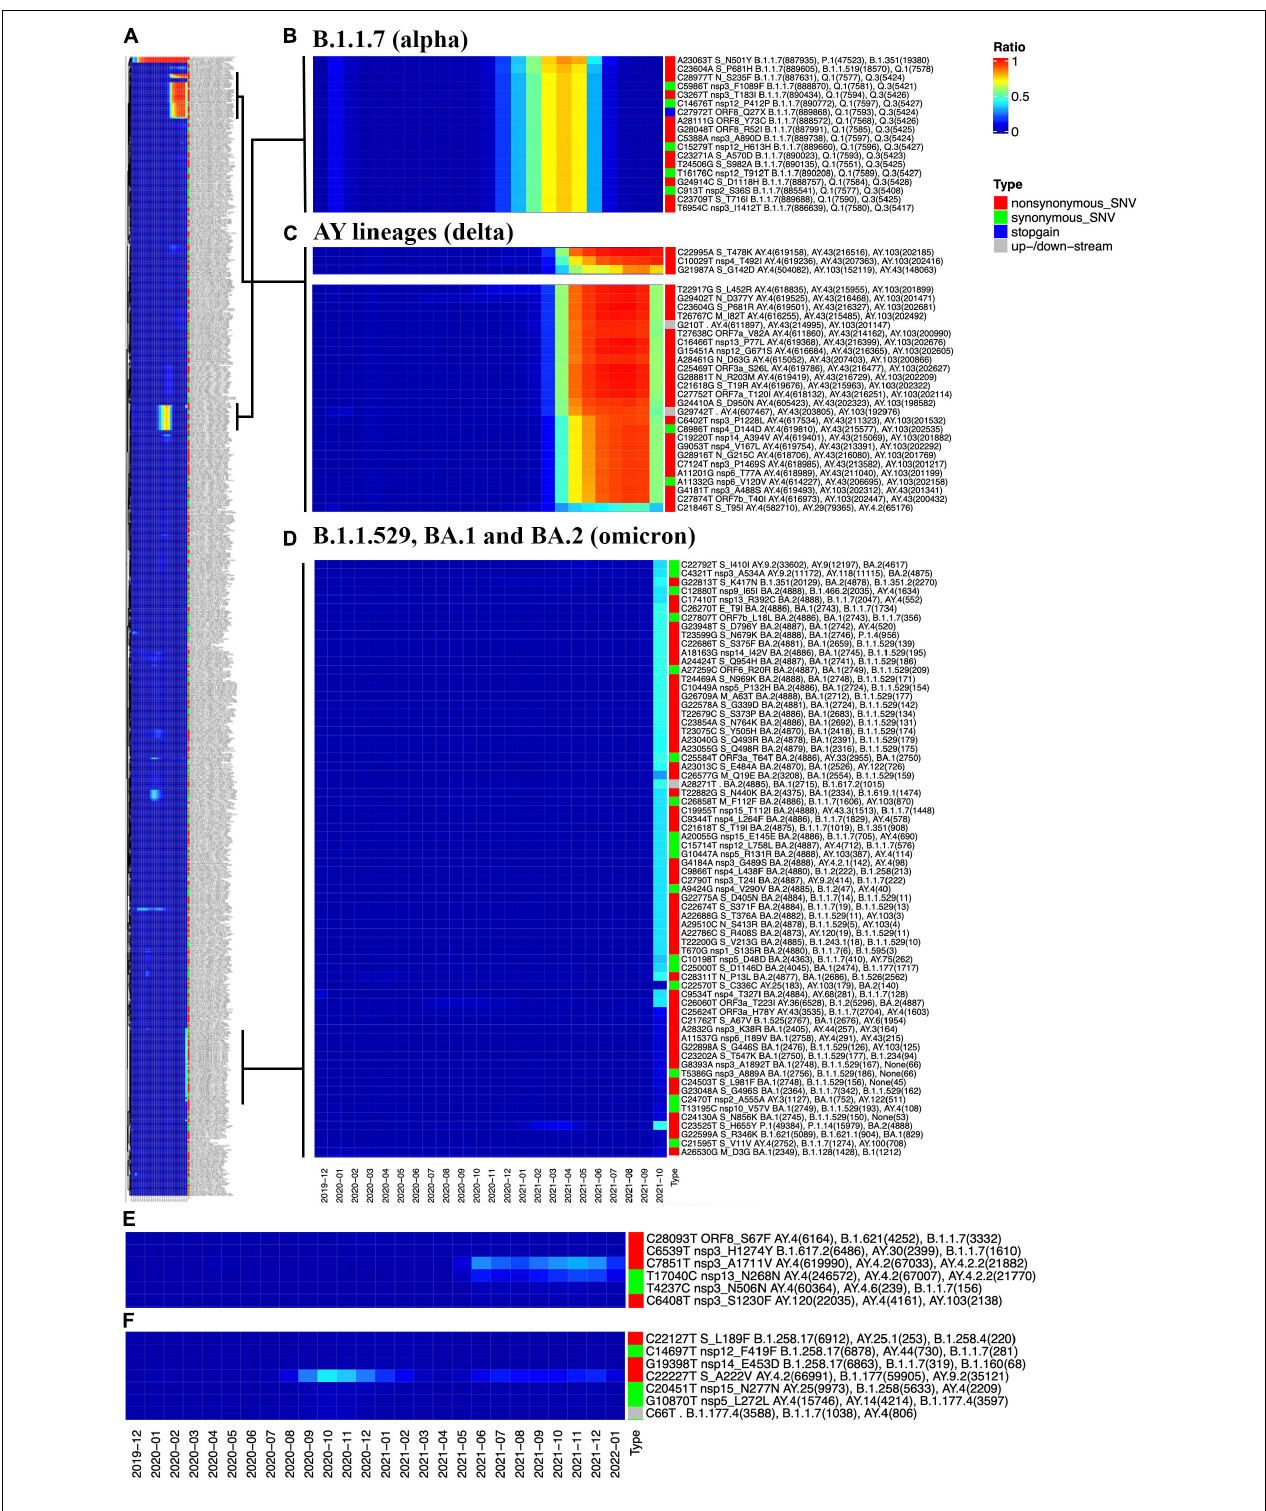
FIGURE 4 | Overview of the “SNV Frequency Heatmap.” (A) The full-size heatmap of SNV frequencies as of January 21, 2022. (B) The heatmap of B.1.1.7 (i.e., alpha) SNVs. (C) The heatmap of AY lineages (i.e., delta) SNVs. (D) The heatmap of B.1.1.529 (i.e., omicron) SNVs, including SNVs specific to BA.1 or BA.2. (E) The increasing path of a group of SNVs, including C7851T and T17040C from AY.4 and AY.4.2. (F) The wave pattern of C22227T, showing that its frequency reached the peak in October and November 2020, then dropped in January and February 2021, followed by a rise again since June 2021.